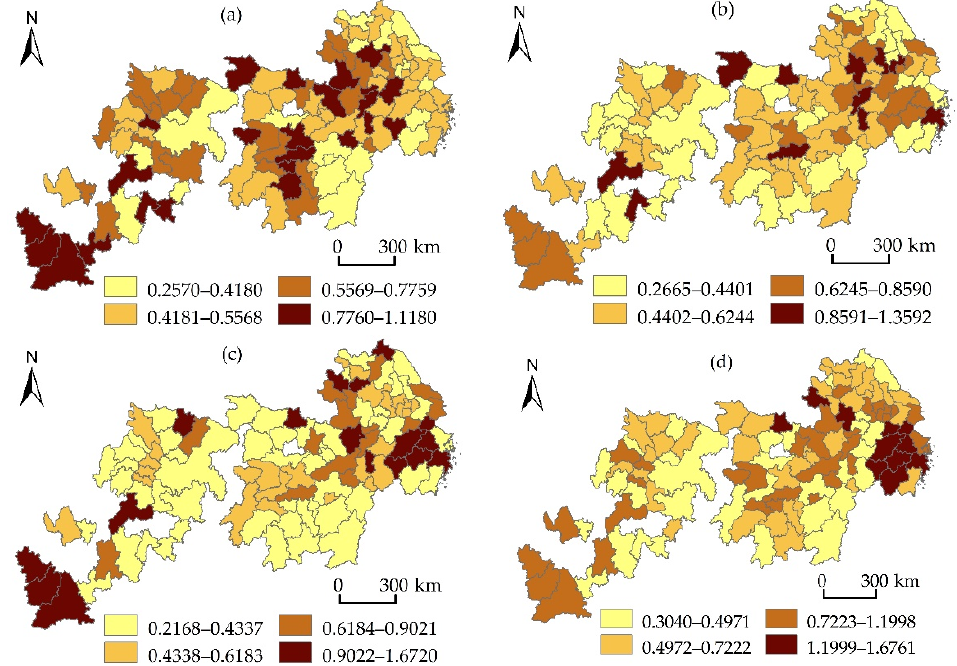
Figure 3. Spatial differentiation of the ULUE. ( a ) The ULUE in 2005; ( b ) the ULUE in 2009; ( c ) the ULUE in 2014; ( d ) the ULUE in 2019.